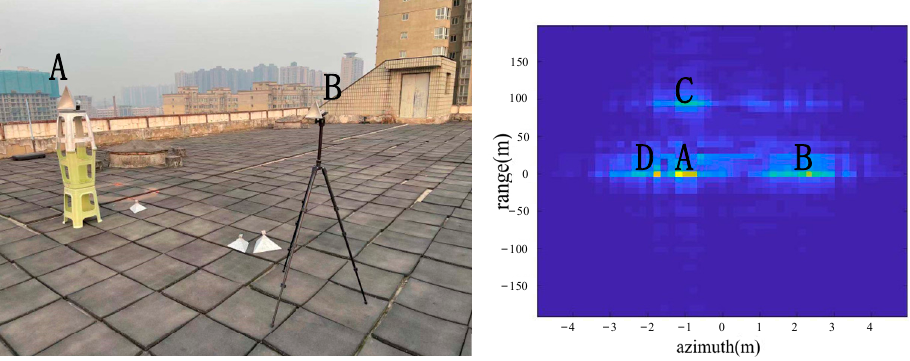
Figure 9. The 4th group of experimental scenes and imaging results. As shown in Figure 10, a corner reflector A was placed in the azimuth direction 17 m from the radar, and the corner reflector A was positioned to the left of the center position in the azimuth direction. A was a medium-sized corner reflector, but the reflection of A was still obvious. Corner reflector B does not appear in the image because corner reflector B was lying on the ground. According to the imaging results, the positions of A, C and D were consistent with the positions of objects in the actual scene. As shown in Figure 11, a corner reflector A was placed in the azimuth direction 17 m from the radar, and the corner reflector A was placed to the left of the center of the azimuth direction. A was a small corner reflector; thus, the reflection of A was not very strong. According to the imaging results, the positions of A, C and D were consistent with the positions of objects in the actual